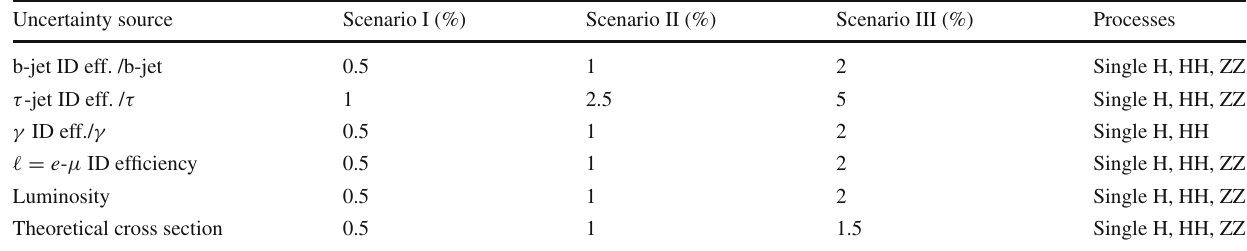
Table 3 Summary of the sources of systematic uncertainties in the 3 scenarios. The last column indicates the processes that are affected by the corresponding source of uncertainty. For each given object (b-jet,